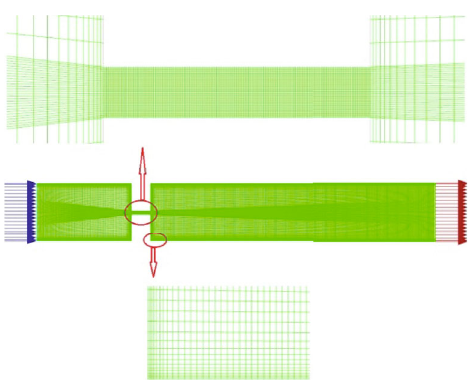
Figure 11: Schematic diagram of mesh.